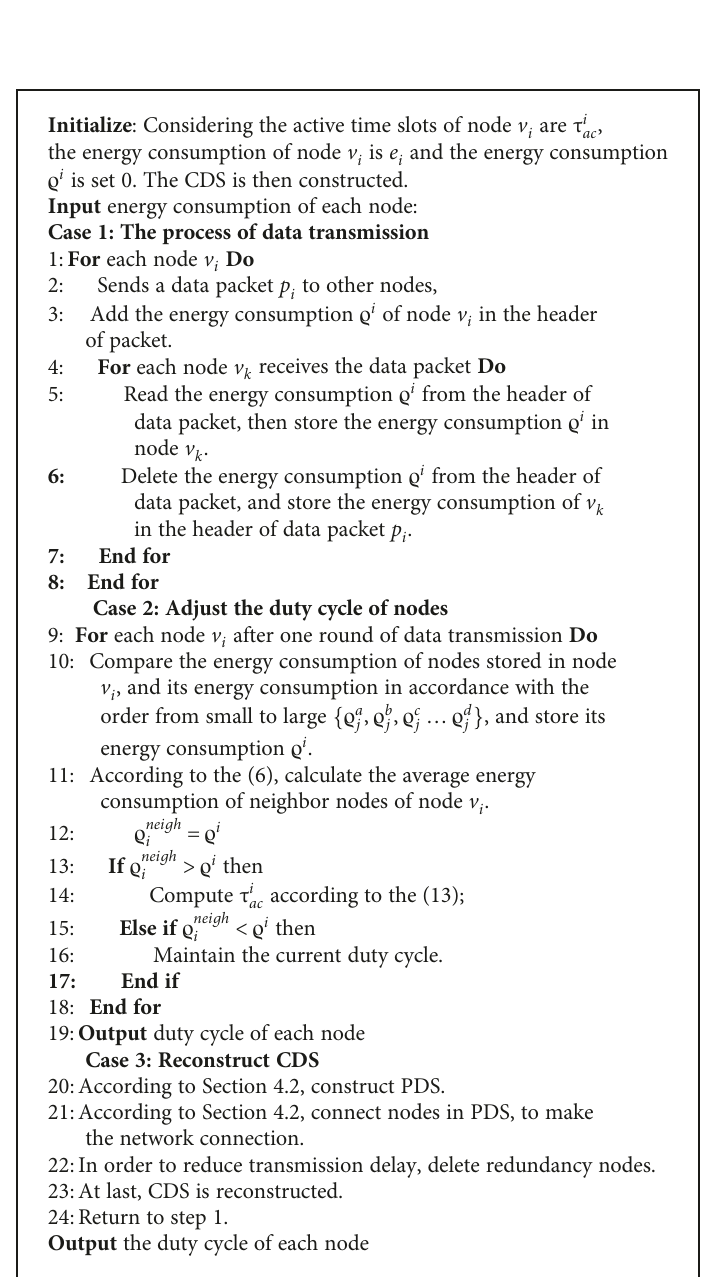
Algorithm 1: The ADCC scheme for adjusting duty